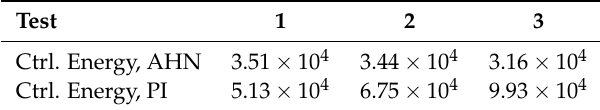
Table 3. Comparison of Robust Scheme and PI: Control